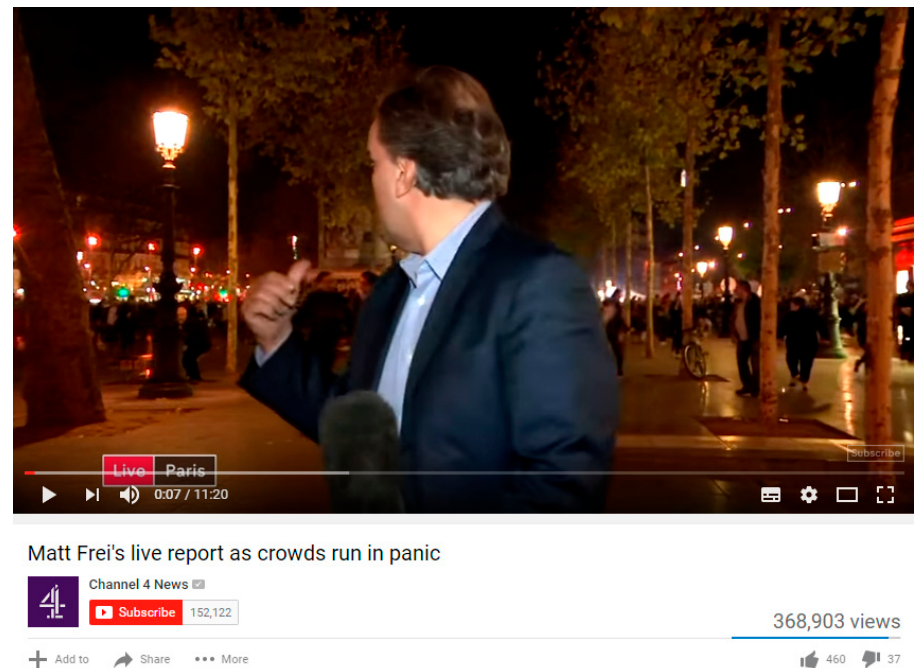
Figure 1. Frei reporting on the aftermath of the 15 November 2015 terror attacks in Paris.